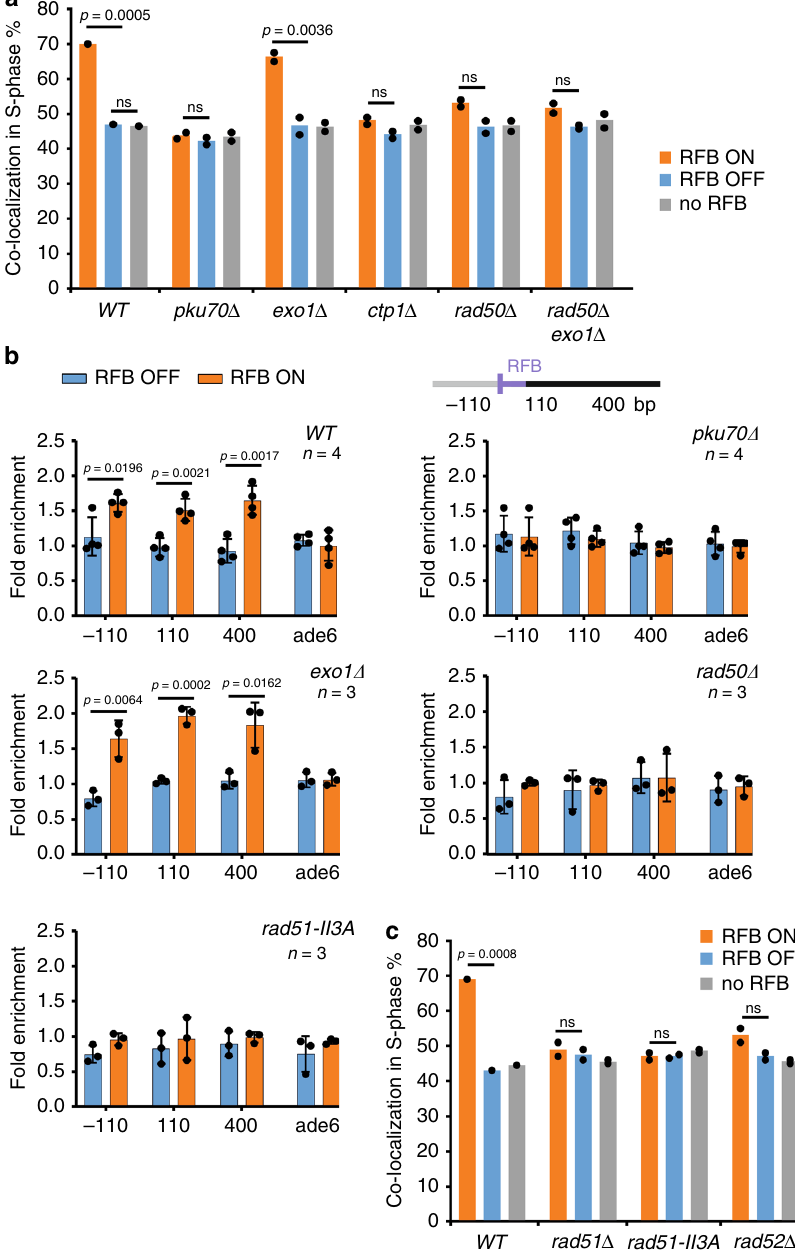
Fig. 2 Relocation to NPCs requires Rad51 enzymatic activity. a Co-localization events in S-phase cells in indicated conditions and strains, as described on Fig. 1b, c. p value was calculated by Fisher ’ s exact test for OFF and ON groups for each mutant and condition. In all, 200 cells were analyzed for each strain and condition. Dots represent values obtained from two independent biological experiments. For each set of data, WT strain was analyzed alongside mutants. b Binding of Npp106-GFP to the RFB in indicated strains. Upstream and downstream distances from the RFB are presented in bp (top). Primers targeting ade6 gene were used as unrelated control locus. Values are mean of n independent biological repeats, with SD as error bars. p value was calculated using two-sided t -test. c Co-localization events in S-phase cells in indicated conditions and strains, as in a